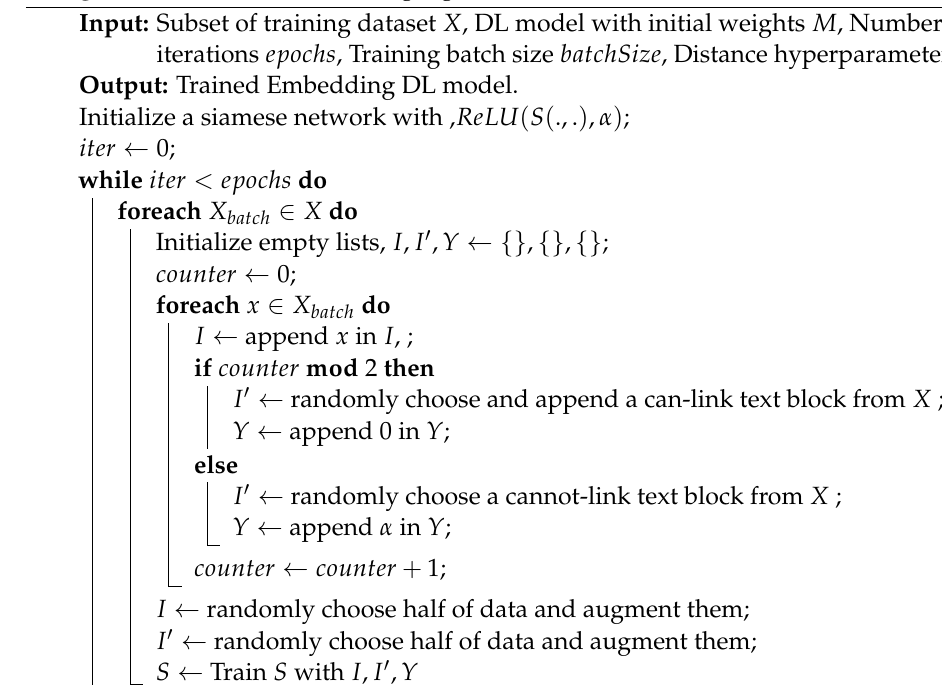
Algorithm 1: Self-Writer training